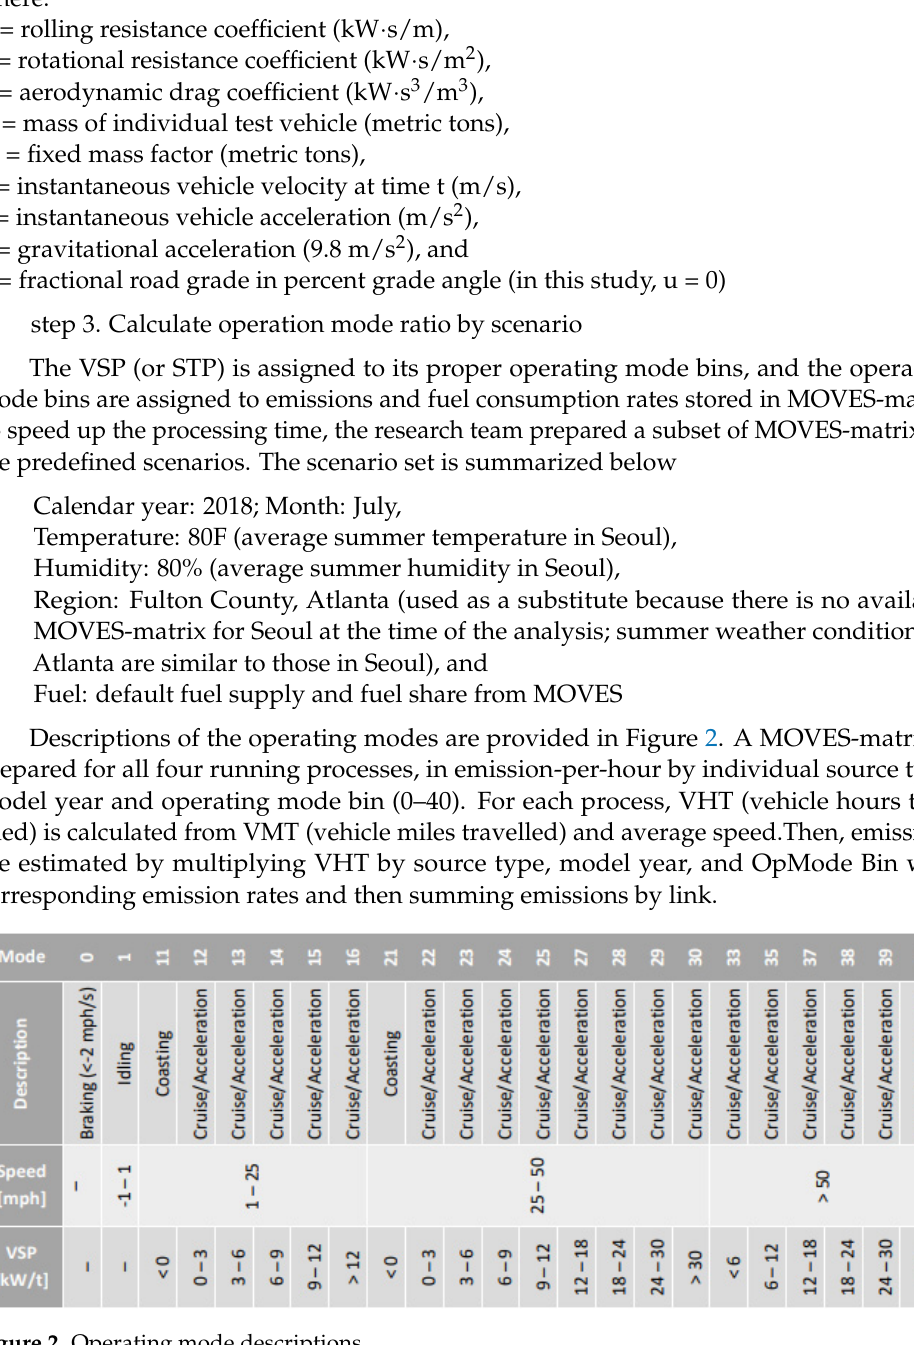
Figure 2. Operating mode descriptions.